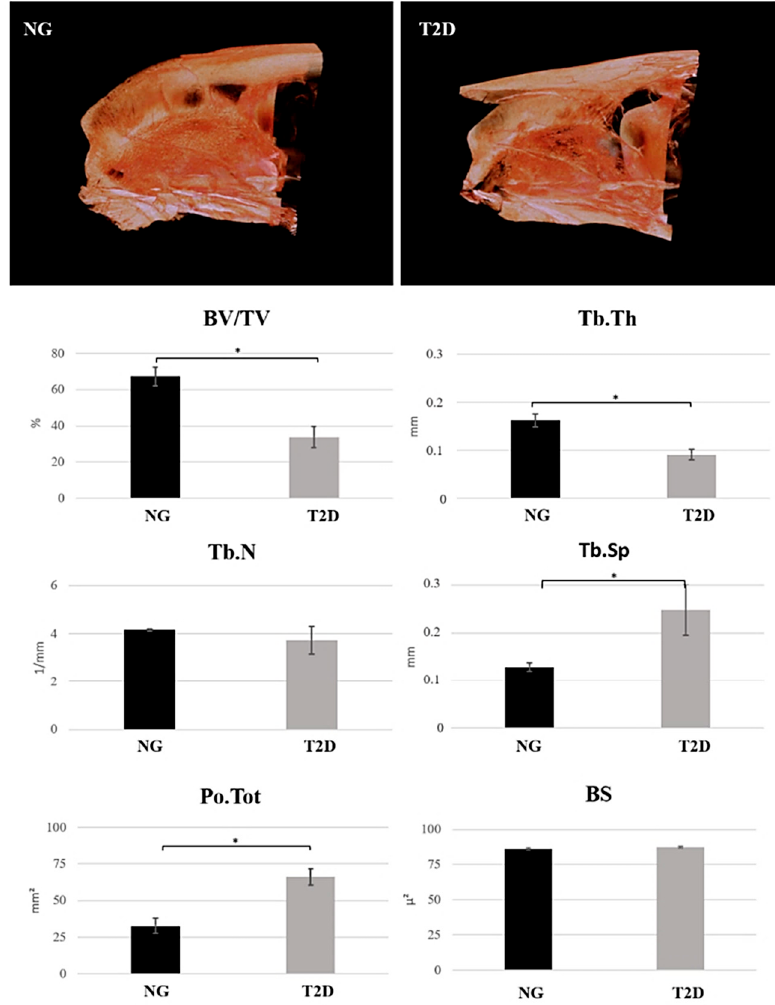
Figure 3. Scan and graphs showing Micro-CT results. Representative image of NG and T2D maxilla. BV/TV: T2D group have a lower numerical value of bone volume percentage when compared to the NG group, with statistically significant difference between the groups. Tb.Th: T2D group have a lower numerical value of trabecular thickness when compared to the T2D group with statistically significant difference between the groups. Tb.N: There is no statistically significant difference in the number of trabeculae between groups. Tb.Sp: T2D have a higher trabecular separation when compared to NG group, with statistically significant difference between the groups. Po.Tot: 2D have a total porosity when compared to NG group, with statistically significant difference between the groups. BS: There is no statistically significant difference in the bone surface area between groups. Symbols: Error bar; * p <0.05.